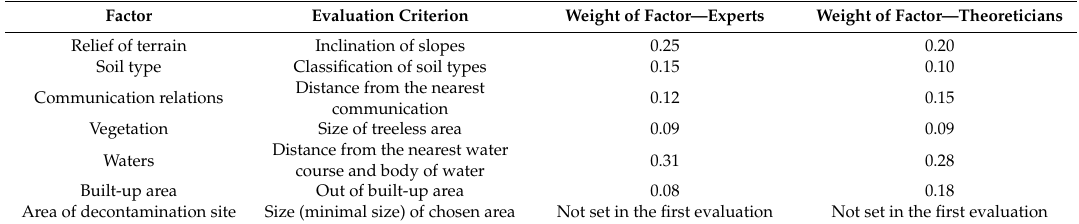
Table 7. Weights of factors and evaluation criteria—experts and theoreticians.